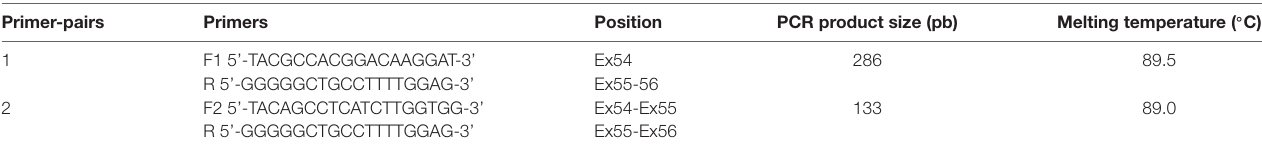
TABLE 1 | CDH23 primers for RT-PCR analysis.